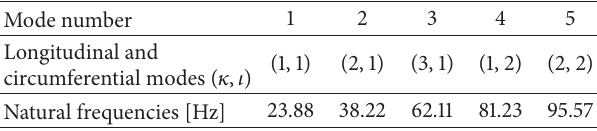
Table 4: Natural frequencies of the plate (before active